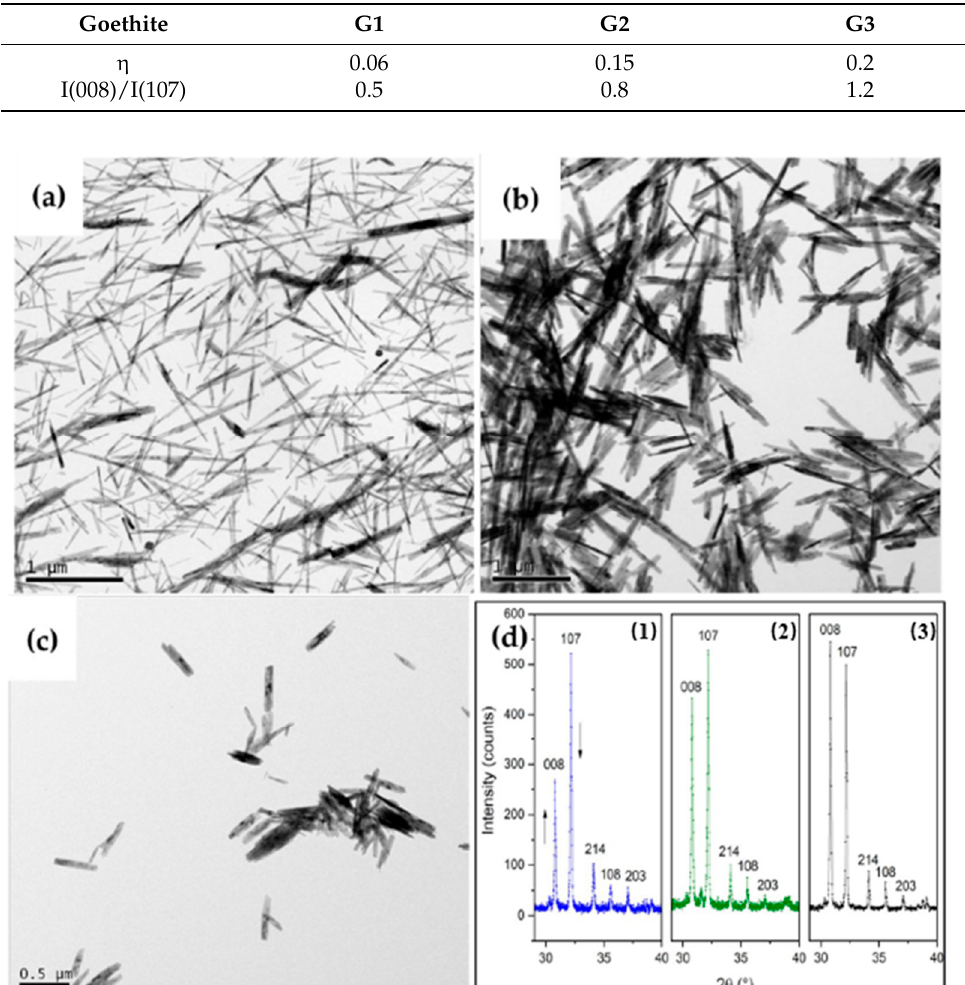
Figure 2. ( a – c ) Goethites G1, G2, G3, respectively. ( d ) X-Ray pattern of oriented BaM samples ( 1 – 3 ) obtained with G1, G2, G3, respectively.